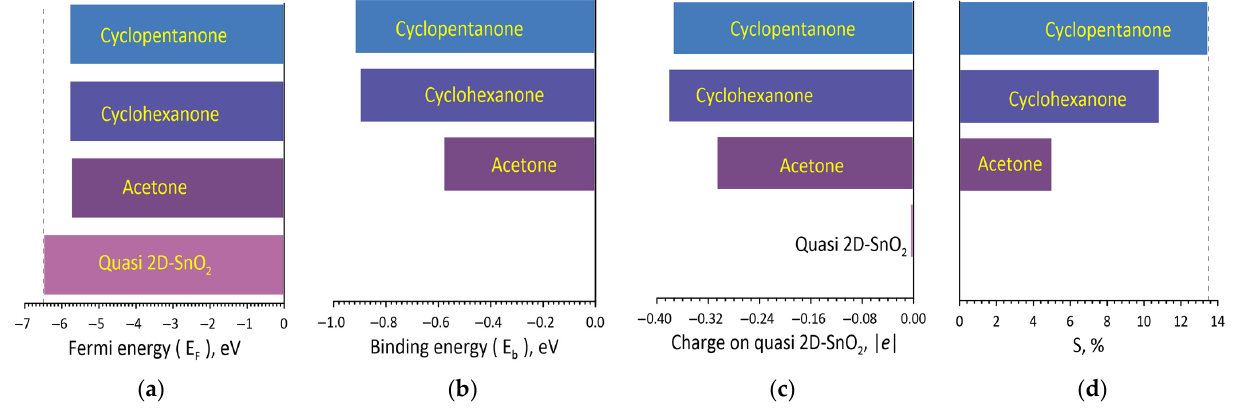
Figure 4. The diagrams of the Fermi energy ( a ), the ketone–surface binding energy ( b ), the values of the charge transfer from the ketone to the surface ( c ) and the magnitude of the chemoresistive response S of the SnO 2 film during adsorption of ketones ( d ).